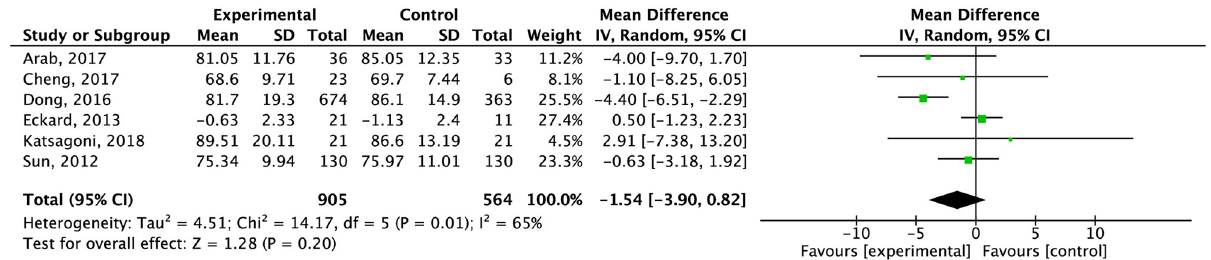
Fig 3. Effect of exercise plus diet compared to the control group in body weight.